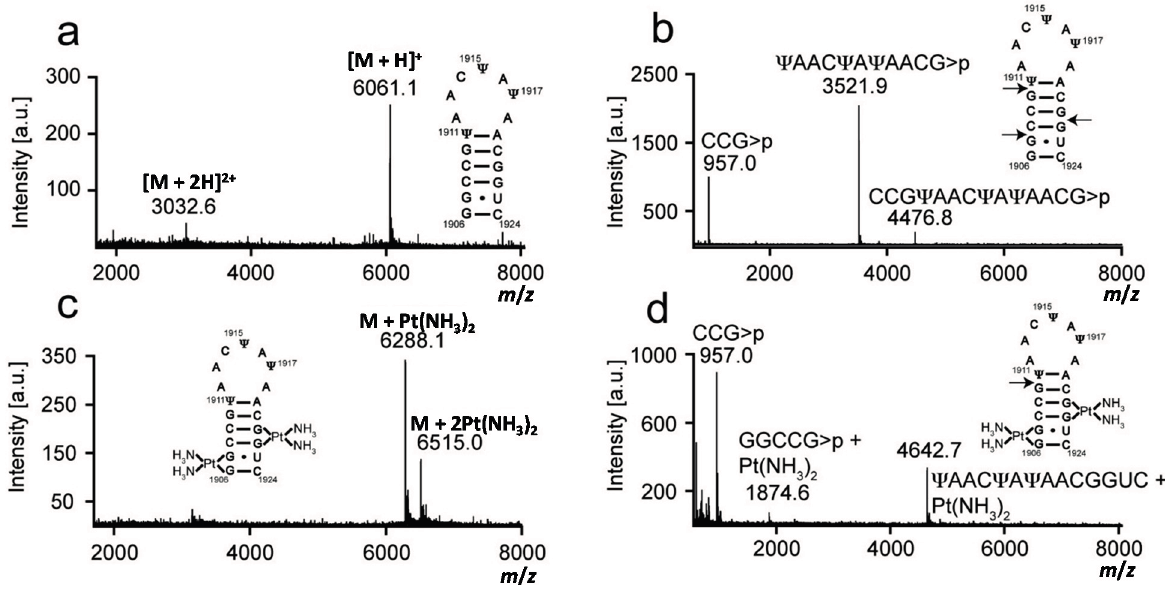
Figure 3. Mass analysis of platinated modified H69 is shown. Mass spectra of ( a ) modified H69 parent RNA (unplatinated RNA); ( b ) RNase T1 digestion of unplatinated H69; ( c ) platinated modified H69; and ( d ) RNase T1 digestion of platinated modified H69 are given. Arrows indicate RNase T1 cleavage